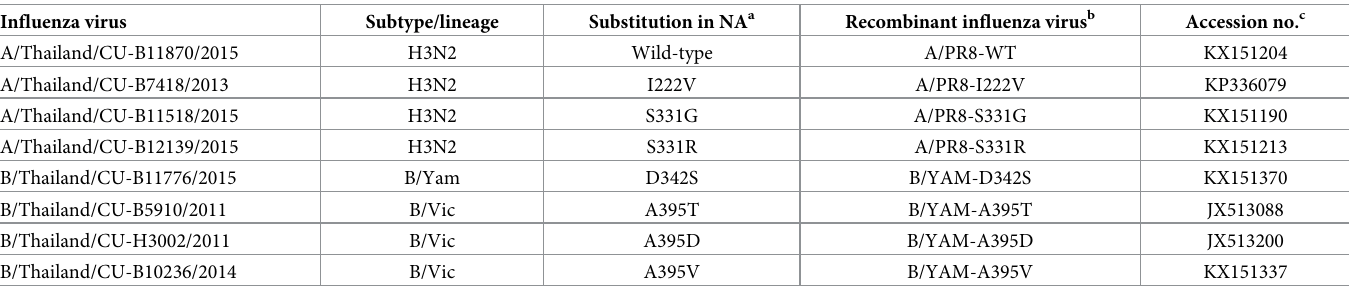
Table 1. Novel NA substitutions in influenza A(H3N2) and B PCR-positive samples from Thailand used in the study. Influenza